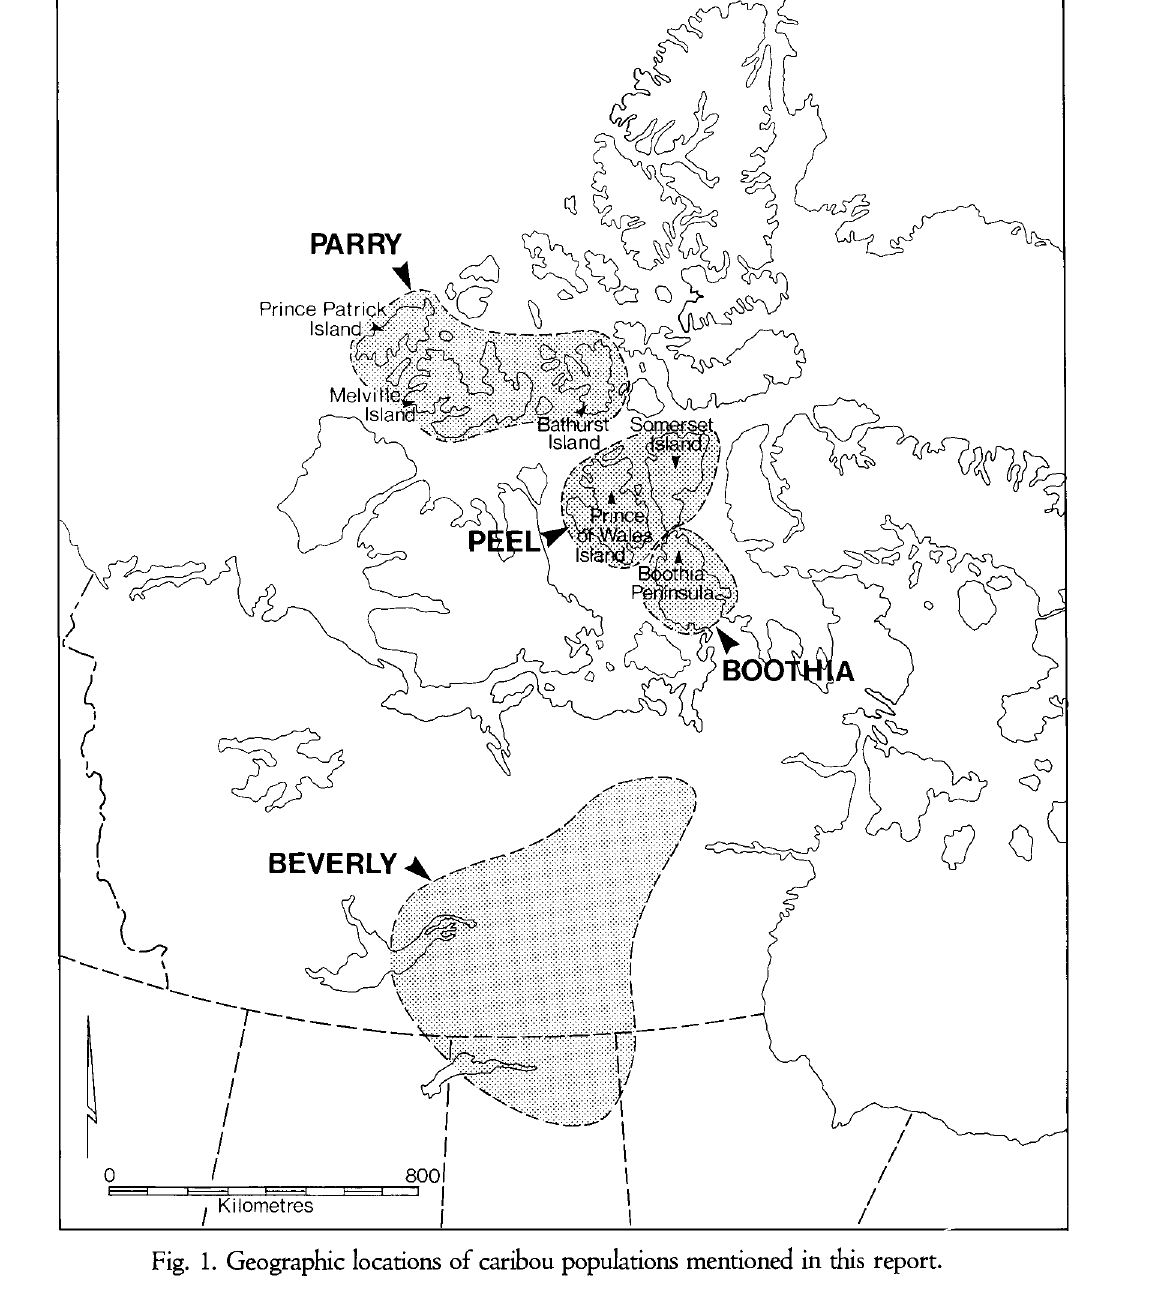
Fig. 1. Geographic locations of caribou populations mentioned in this report.